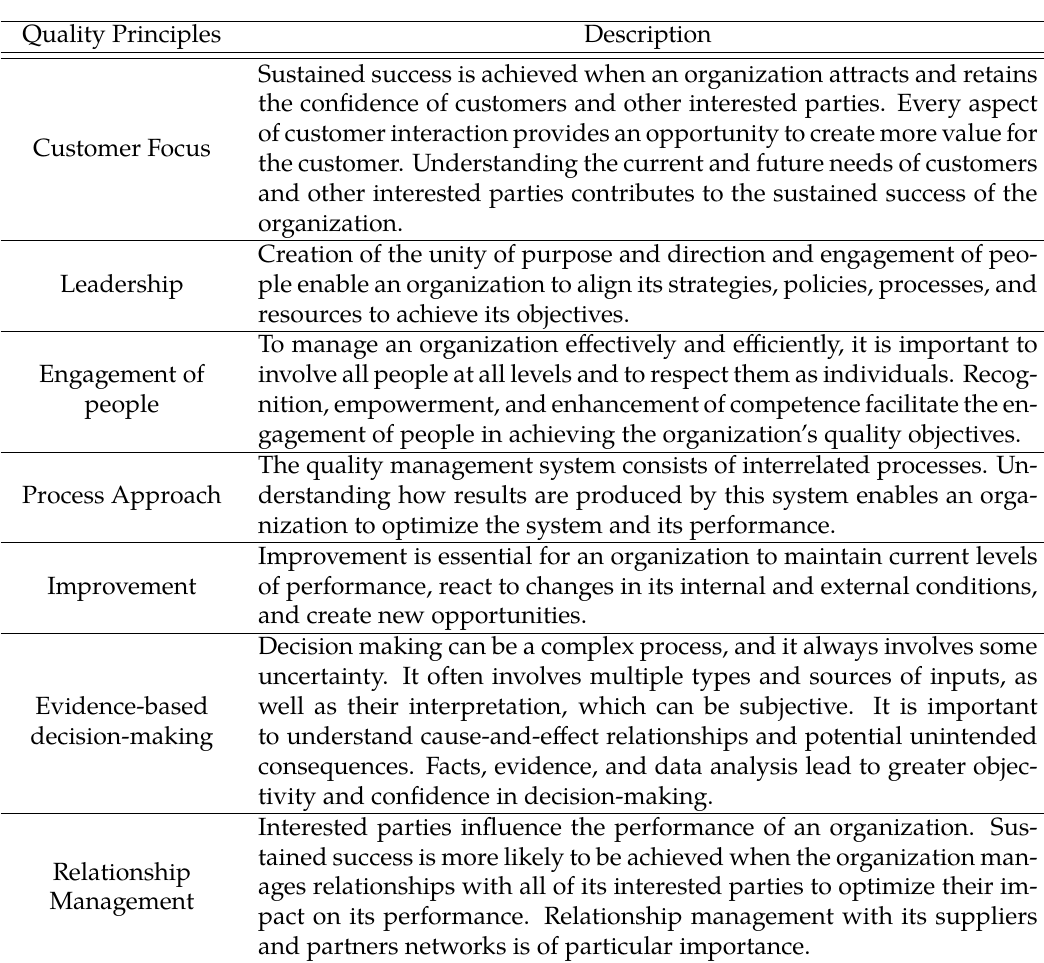
Table 1: ISO Quality Management